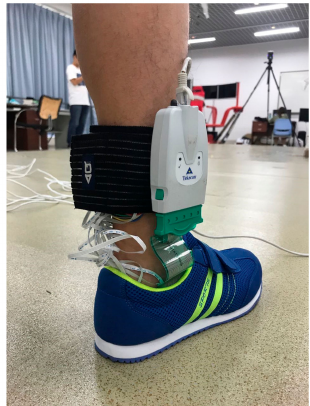
Figure 4. Both the lower-shank mounted block of the instrumented insole and the signal box of the F-scan system were attached to the lower-shank.